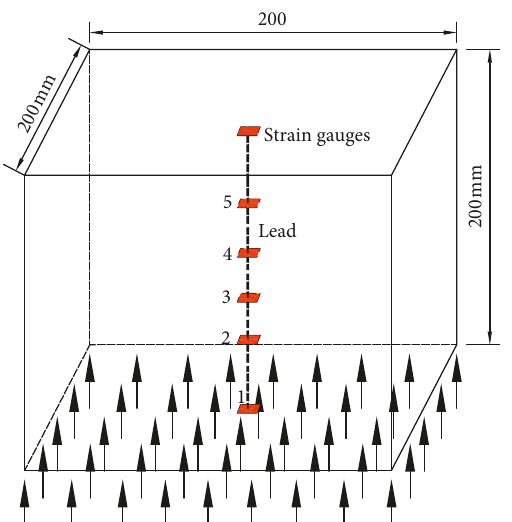
Figure 7: Sketch map of stress wave propagation in the intact rock mass.